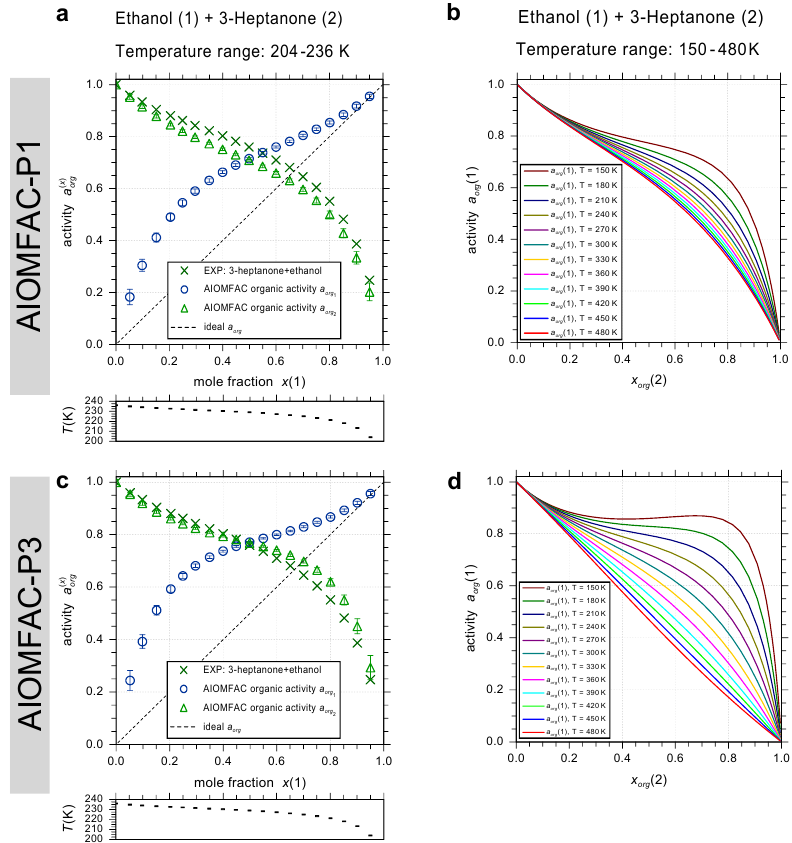
Figure 9. SLE measurements for ethanol (1) + 3-heptanone (2) solutions and corresponding calculations of AIOMFAC-P1 (a, b) or AIOMFAC-P3 (c, d) . Panels (b, d) show the temperature dependence predictions from AIOMFAC-P1 and AIOMFAC-P3 for the tem- perature range 150–480K. The SLE data in (a, c) show the composition (mole fraction of ethanol) against activity of 3-heptanone. The error bars represent the model sensitivity to a composition variation by x tol = 0 . 01. The dashed line is the ideal solution curve for component 1. Experimental data: Fiege et al.